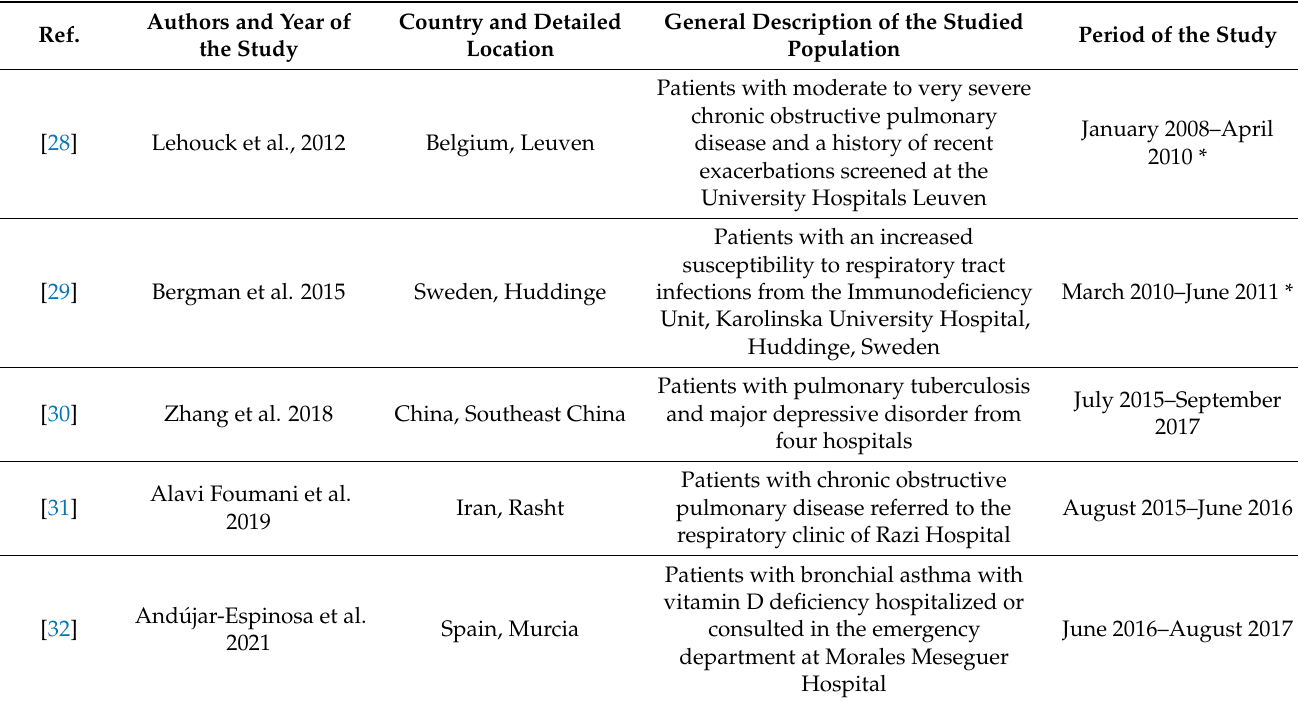
Table 2. The general descriptions of the studies included in the systematic